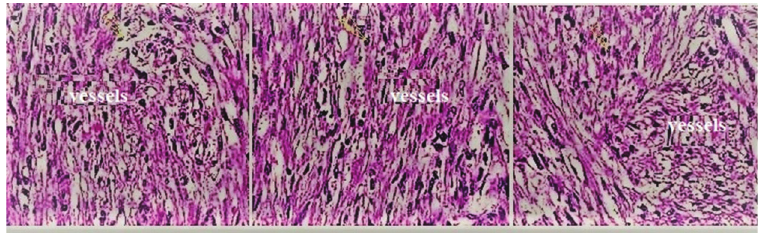
Figure 9 - Histopathological examinations of the three contradictory cases of angiomyolipoma that were actually of papillary renal cell carcinoma. All three cases consisted of varying amounts of smooth muscle cells, mature fat and thick-walled vessels. Additionally, abnormal vessels were often hyalinized and thick with eccentric lumen, and smooth muscle cells appeared to originate and ‘‘ radiate ’’ off the vessels. The yellow arrow indicates smooth muscle